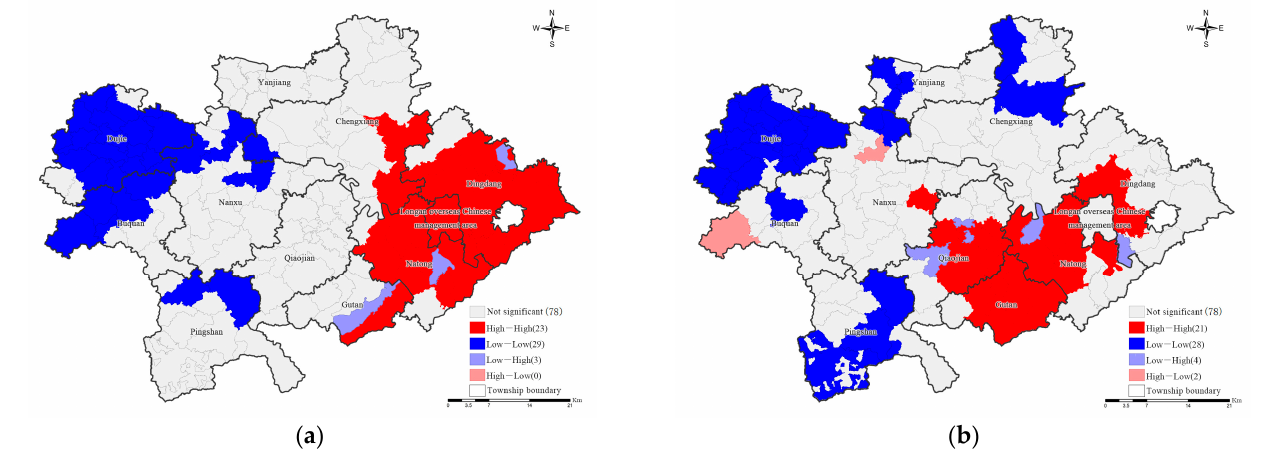
Figure 5. ( a ) Cluster distribution of cultivated land reduction from 2010 to 2020; ( b ) Cluster distribution of cultivated land addition from 2010 to 2020.